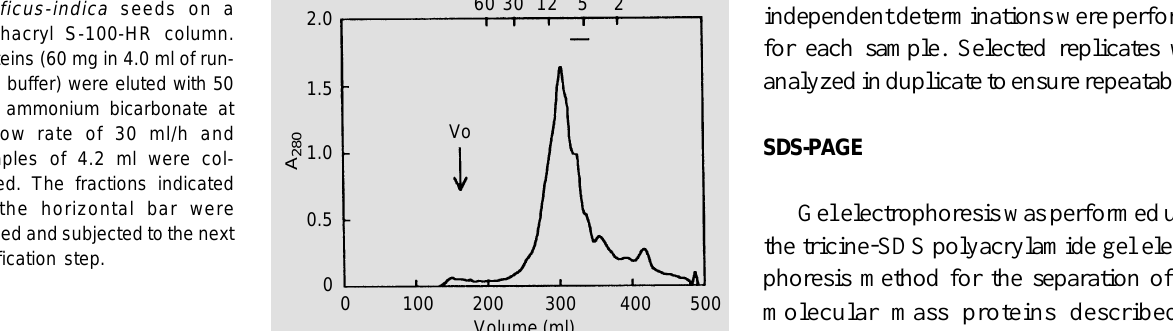
1 - Chromatography of the crude albumin fraction from O. ficus-indica seeds on a Sephacryl S-100-HR column. Proteins (60 mg in 4.0 ml of run- ning buffer) were eluted with 50 mM ammonium bicarbonate at a flow rate of 30 ml/h and samples of 4.2 ml were col- lected. The fractions indicated by the horizontal bar were pooled and subjected to the next purification